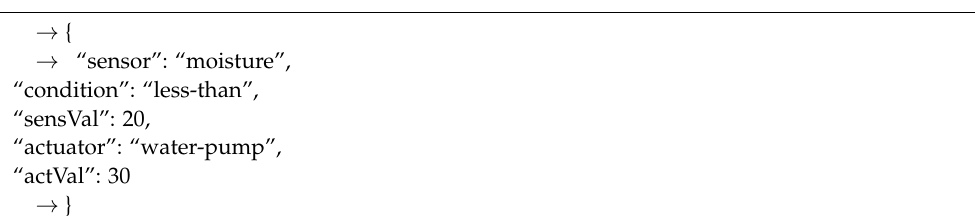
Algorithm 1. Example of a rule. This rule sets the water pump to 30 if the moisture sensor